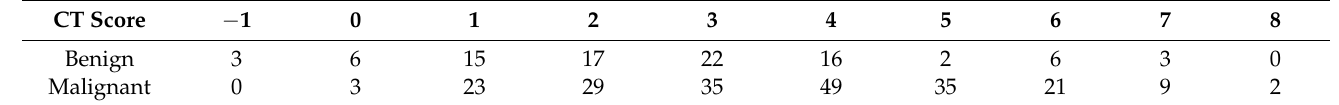
Table 5. Cumulative CT scores for benign and malignant solitary pulmonary